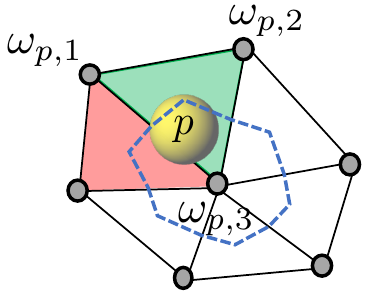
Figure 1. 2D representation of a particle p located in a triangular cell ( ) moving towards a neighboring cell ( ). : mesh nodes. : contour of node 3 control volume. ω p , i : interpolation weight of particle p on node i